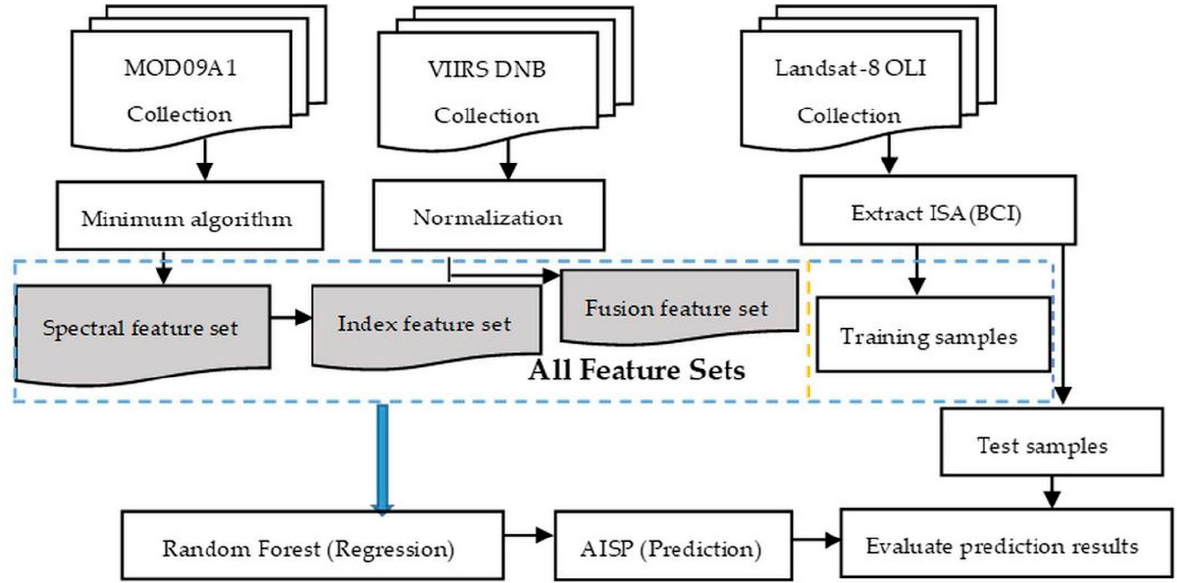
Figure 2. Framework for predicting artificial impervious surface percentage (AISP: artificial impervious surface percentage, BCI: Biophysical Composition Index).